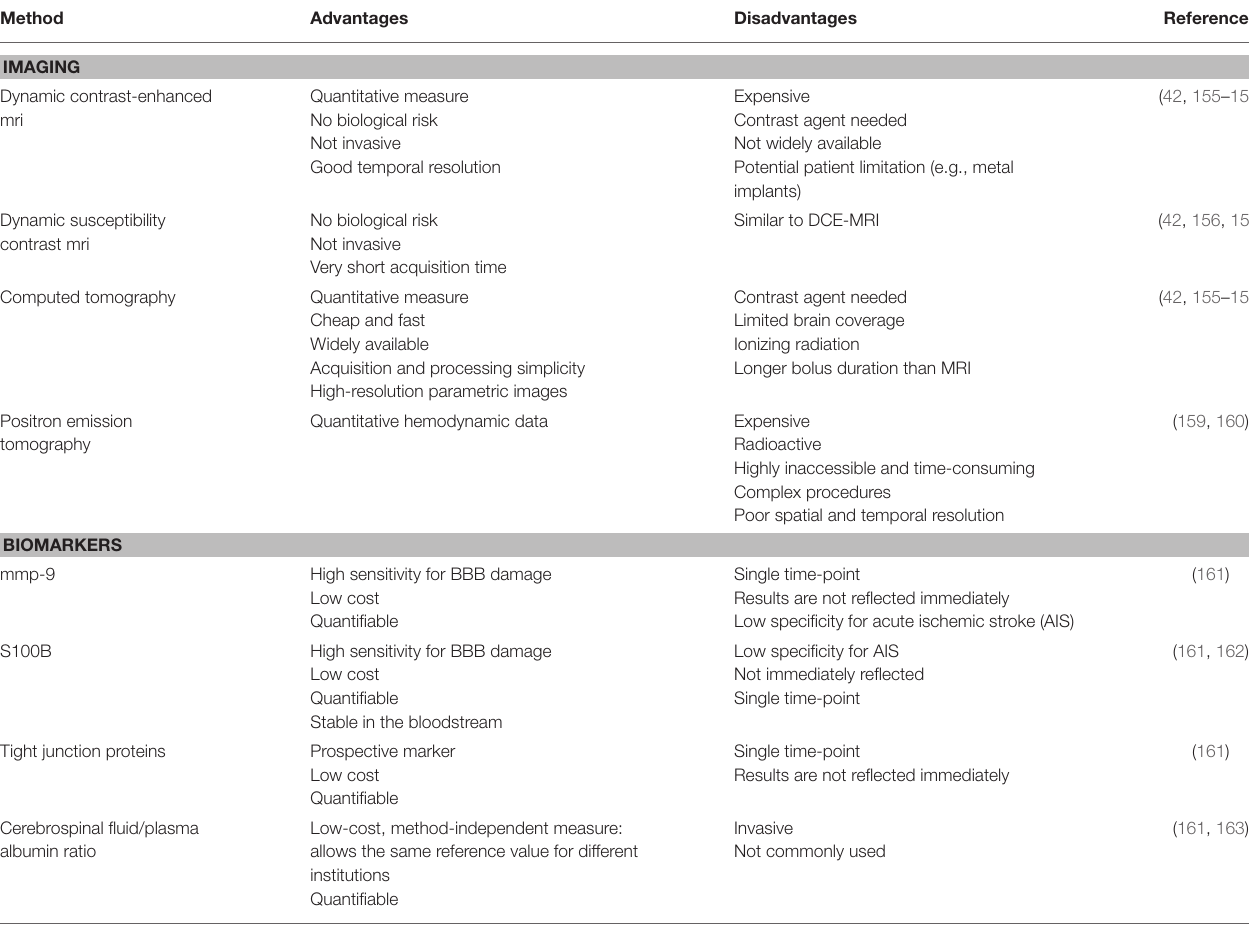
TABLE 1 | Advantages and disadvantages of blood–brain barrier permeability assessment